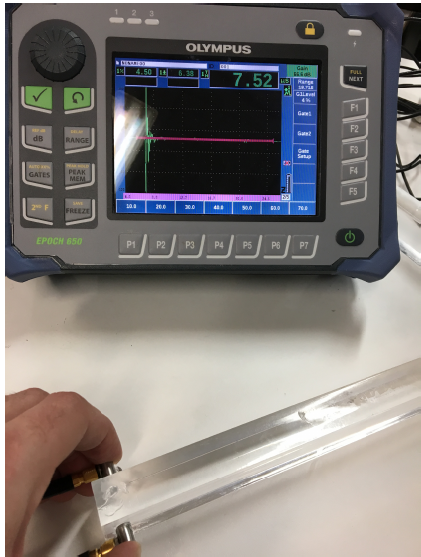
Figure 8. Experimental setup to determine the PMMA